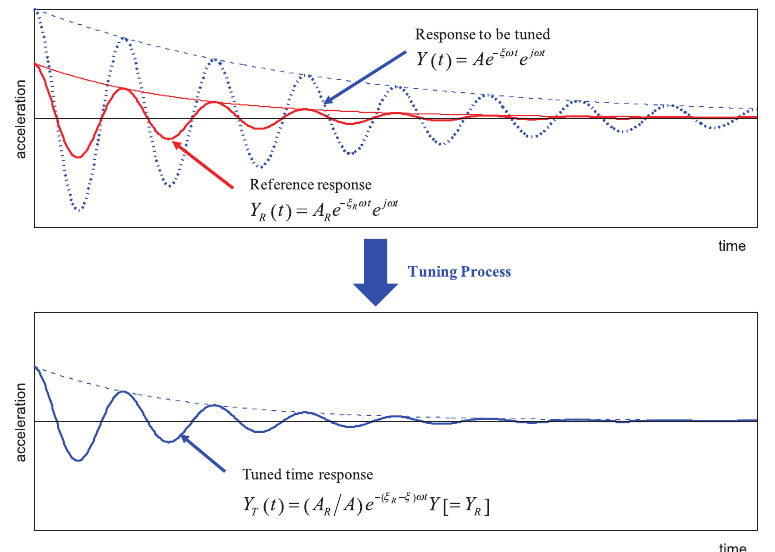
Fig. 4. Tuning of arbitrary shock response time data to reference signal by the amplitude and decay rate